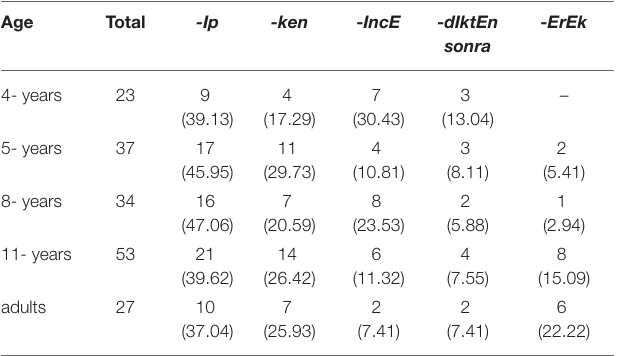
TABLE 5 | Frequency (and percentage) of types of converbal clauses in 1-NCL complex sentences by age.